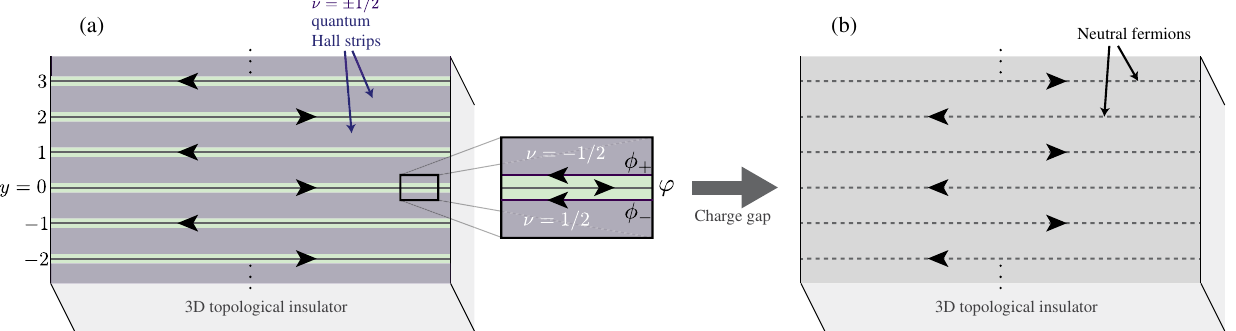
FIG. 3. (a) Magnetic domains of a TI surface overlaid with alternating ν ¼ þ 1 = 2 and − 1 = 2 fractional quantum Hall fluids. The quantum Hall strips cancel the half-integer Hall conductance from the magnetically gapped domains, so that σ xy ¼ 0 everywhere. Each domain wall thus hosts a chiral electron native to the TI surface together with an opposing pair of quantum Hall charge modes. ( “ Spectator ” neutral modes arising from the ν ¼ (cid:2) 1 = 2 states are not shown for simplicity.) When interactions open a charge gap, a set of alternating-chirality neutral fermions remains as in (b). Tunneling between these modes that preserves Dirac cone characteristic of the CDL